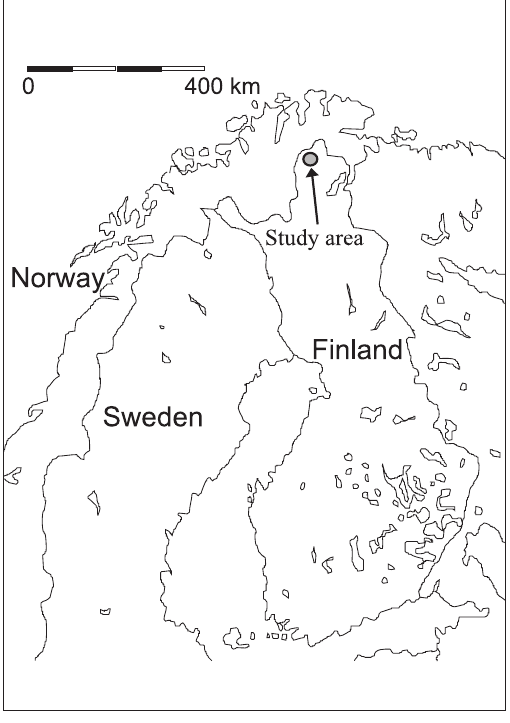
Fig. 1. The study area in northernmost